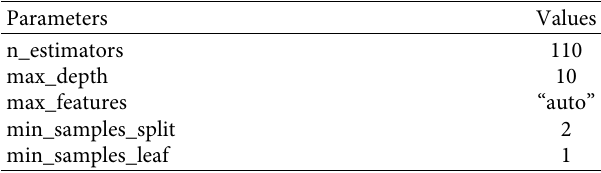
Table 2: Optimal values of parameters of the RF